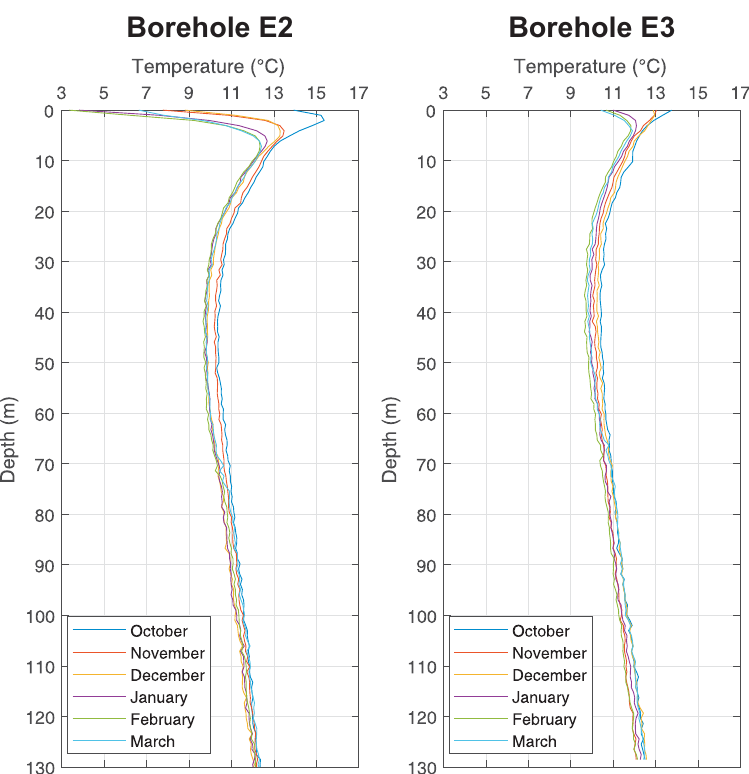
Figure 7. Graph of temperature changes with the depth at chosen monitoring borehole E2 and E3 of the Small Research Polygon .